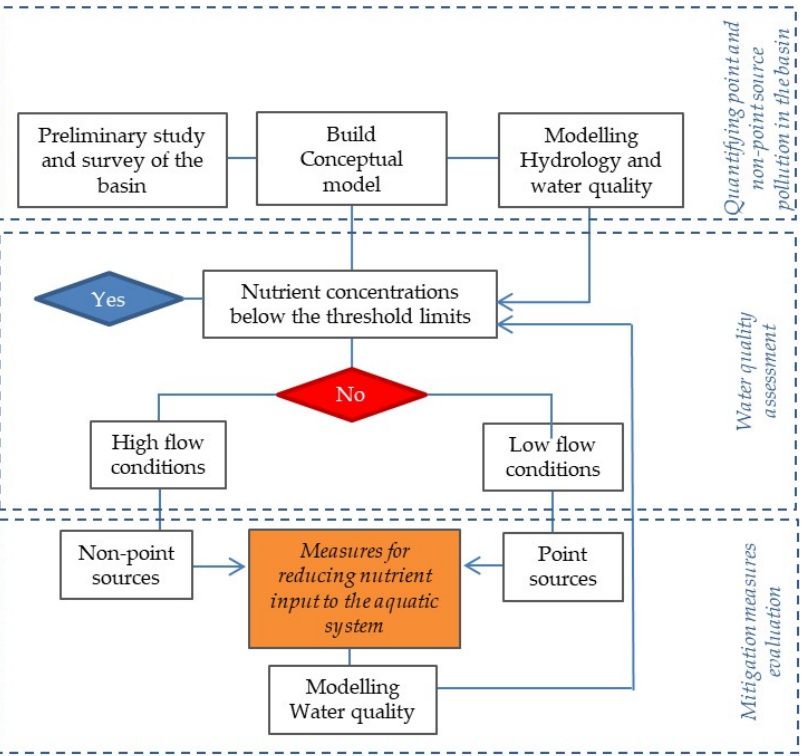
Figure 2. Schematic overview of the method.